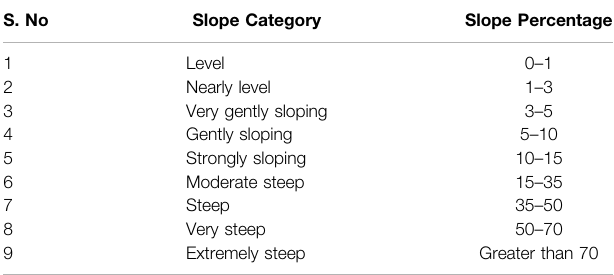
TABLE 4 | Slope Categorized by Soil Survey Manual IARI (1970), Vanniyar basin, Dharmapuri district, Tamil Nadu, India. S. No